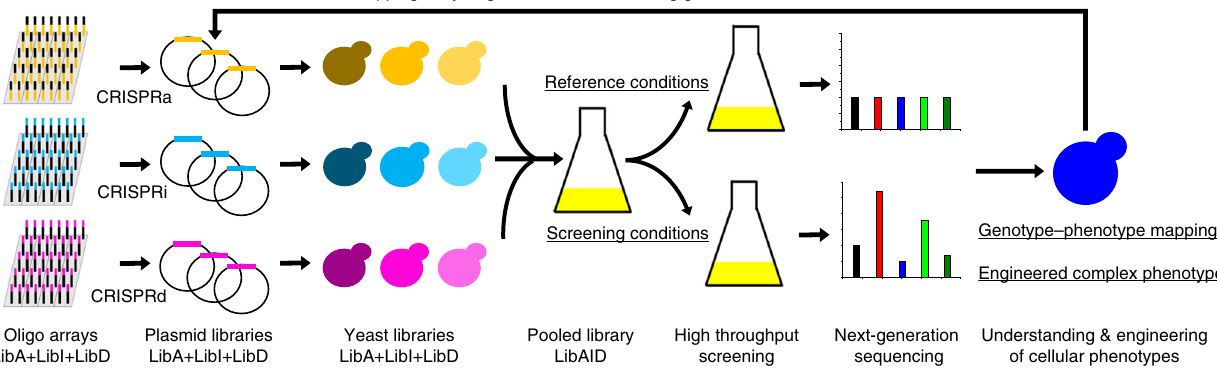
Fig. 1 The MAGIC pipeline for genome-wide mapping genotype – phenotype relationships. Guide sequences for genome-scale activation (orange), interference (light blue), and deletion (magenta) were synthesized as arrayed oligos on DNA chip and cloned into the corresponding gRNA expression plasmids using Golden-Gate Assembly. The iMAGIC library was constructed by transforming the pooled plasmid libraries into the CRISPR-AID integrated yeast strain, and subject to growth enrichment under various conditions or high throughput screening. The enrichment and depletion of guide sequences were pro fi led using next-generation sequencing. The iMAGIC work fl ow can be iterated to better understand and engineer